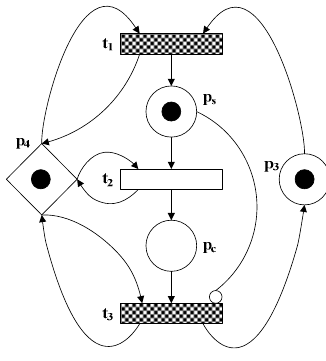
Figure 2. PN model for storage tanks.